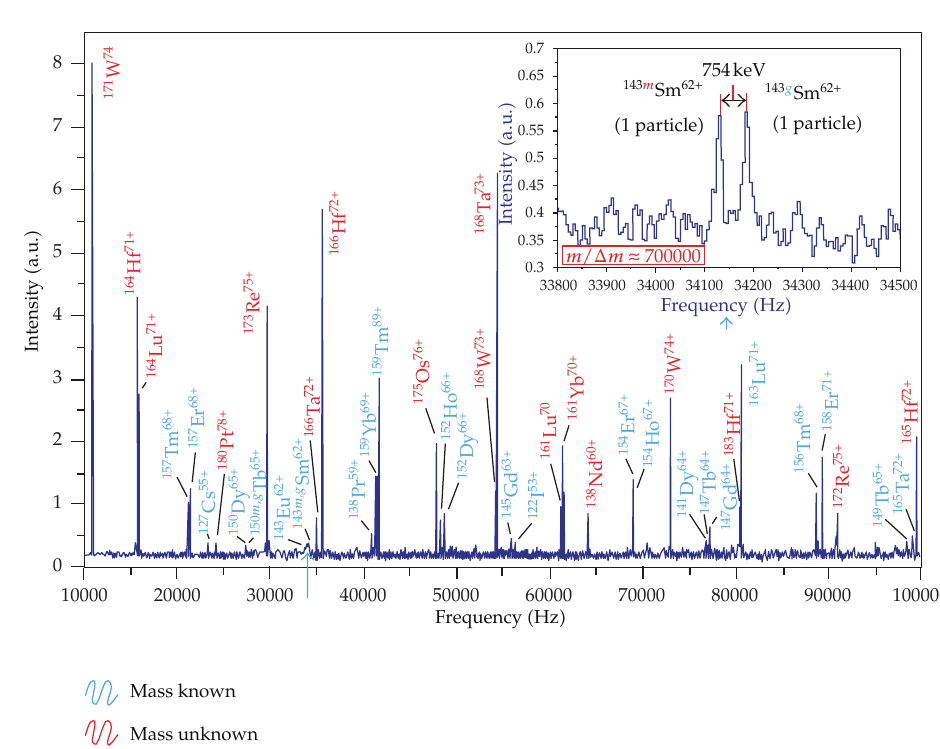
Figure 5: Schottky spectra versus the down-scaled revolution frequencies of stored and cooled nuclei, circulating in the experimental storage ring. Each of the lines shows a di ff erent nuclear species. Since for cooled ions a one-to-one correspondence exists between their revolution frequency and their mass- to-charge ratio, those spectra provide a highly precise mass spectroscopy. The inset shows the Schottky signals of two Sm 62 (cid:4) ions, one of them in the nuclear ground state (cid:2) at the higher frequency (cid:3) , the other one in a metastable state at an excitation energy of 754keV. This demonstrates convincingly the capability of the ESR to detect—with ultimate sensitivity— one single stored and cooled highly-charged ion together with its accurate mass determination (cid:2) Figure by courtesy of Litvinov et al. (cid:6) 23 (cid:7)(cid:3)